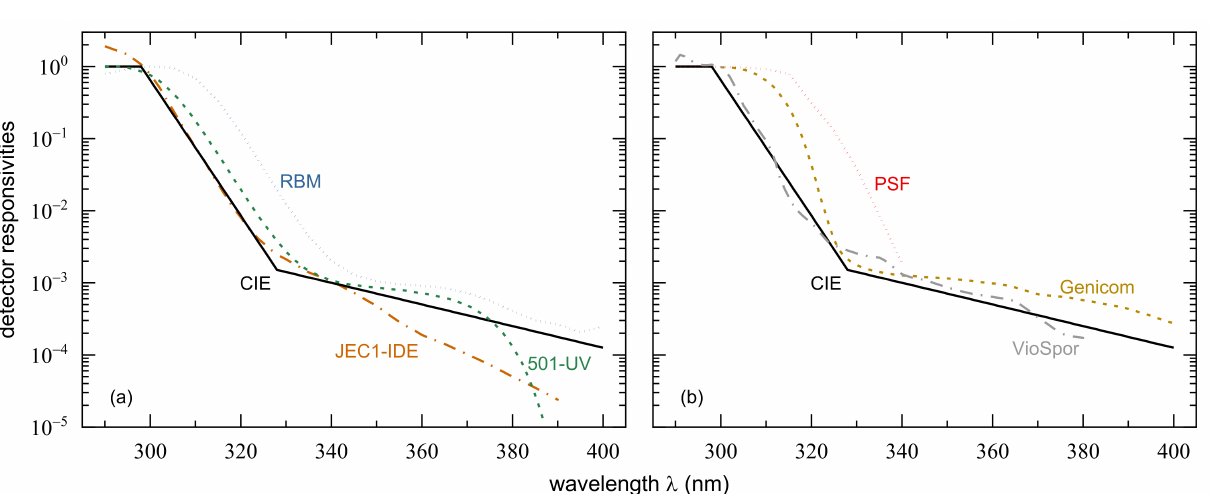
Figure 2. Normalized detector responsivities of ( a ) Robertson–Berger meters (RBM) [41], Solar Light’s Model 501-UV [42], and of the silicon carbide photodiode (JEC1-IDE) used by Heydenreich et al. [43]. ( b ) Relative spectral response of the Genicom UVB dosimeter employed by Grandahl et al. [44], of a 40 µ m thick polysulphone film (PSF) [45], and VioSpor’s mutant strain UVR detection system [46]. The CIE erythema reference action spectrum [24] is depicted in both panels for better comparison. Further information is given in Table 1